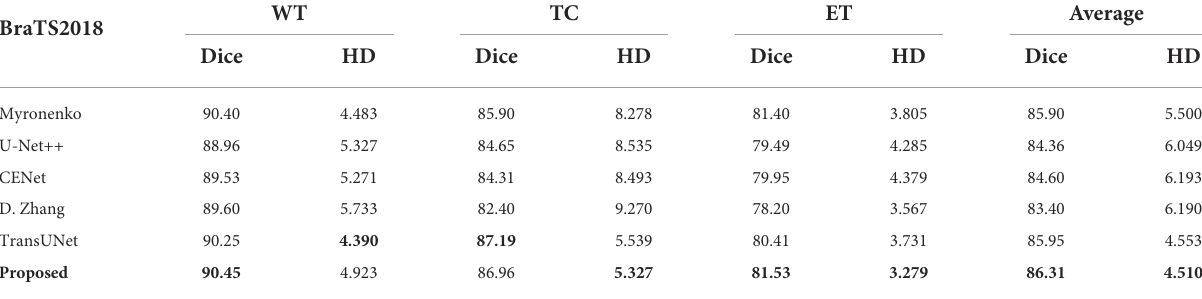
TABLE 1 Comparison of segmentation metrics on BraTS2018. WT TC ET Average BraTS2018